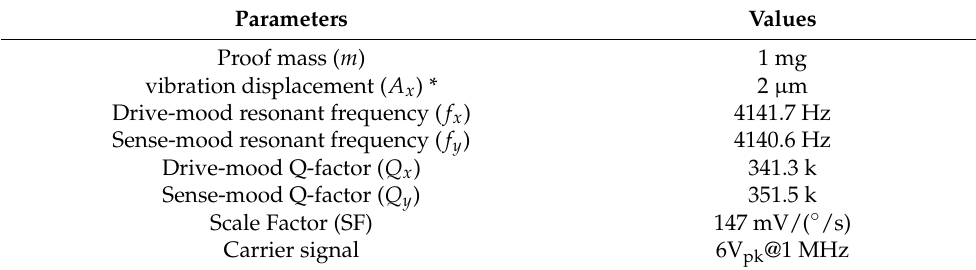
A Xilinx artix-7 series FPGA was used as the gyroscope digital control system plat- Table 3. Basic parameters of gyroscope and circuit. Parameters Values